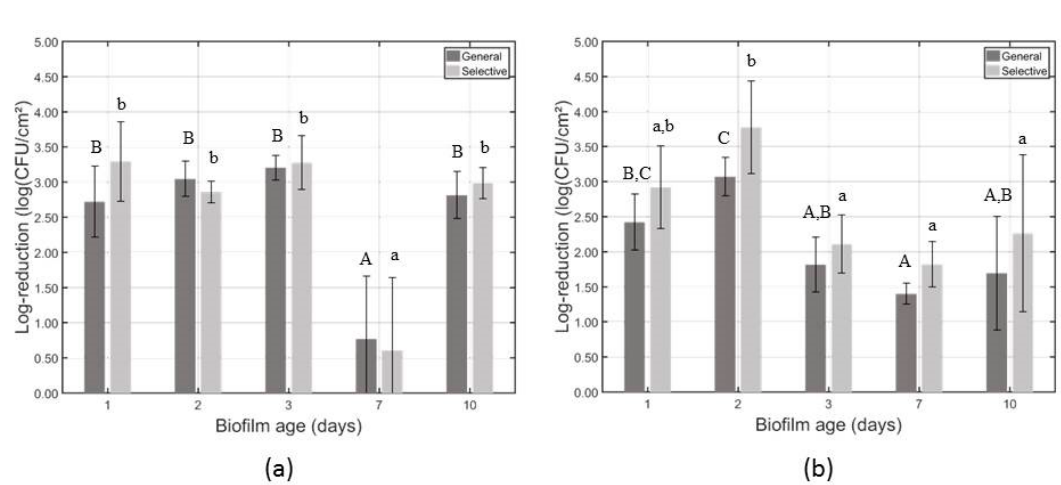
Figure 4. Log ‐ reductions (log(CFU/cm 2 )) obtained on general and selective medium for ( a ) L. monocytogenes and ( b ) S. Typhimurium biofilms treated for 10 min with Cold Atmospheric Plasma (CAP) at optimal inactivation conditions (i.e., DBD, 0.0 ( v / v ) % oxygen, 21.88 V input voltage). Bars bearing different letters (no capital or small letters in common for the general and the selective medium, respectively) are significantly different ( p ≤ 0.05).